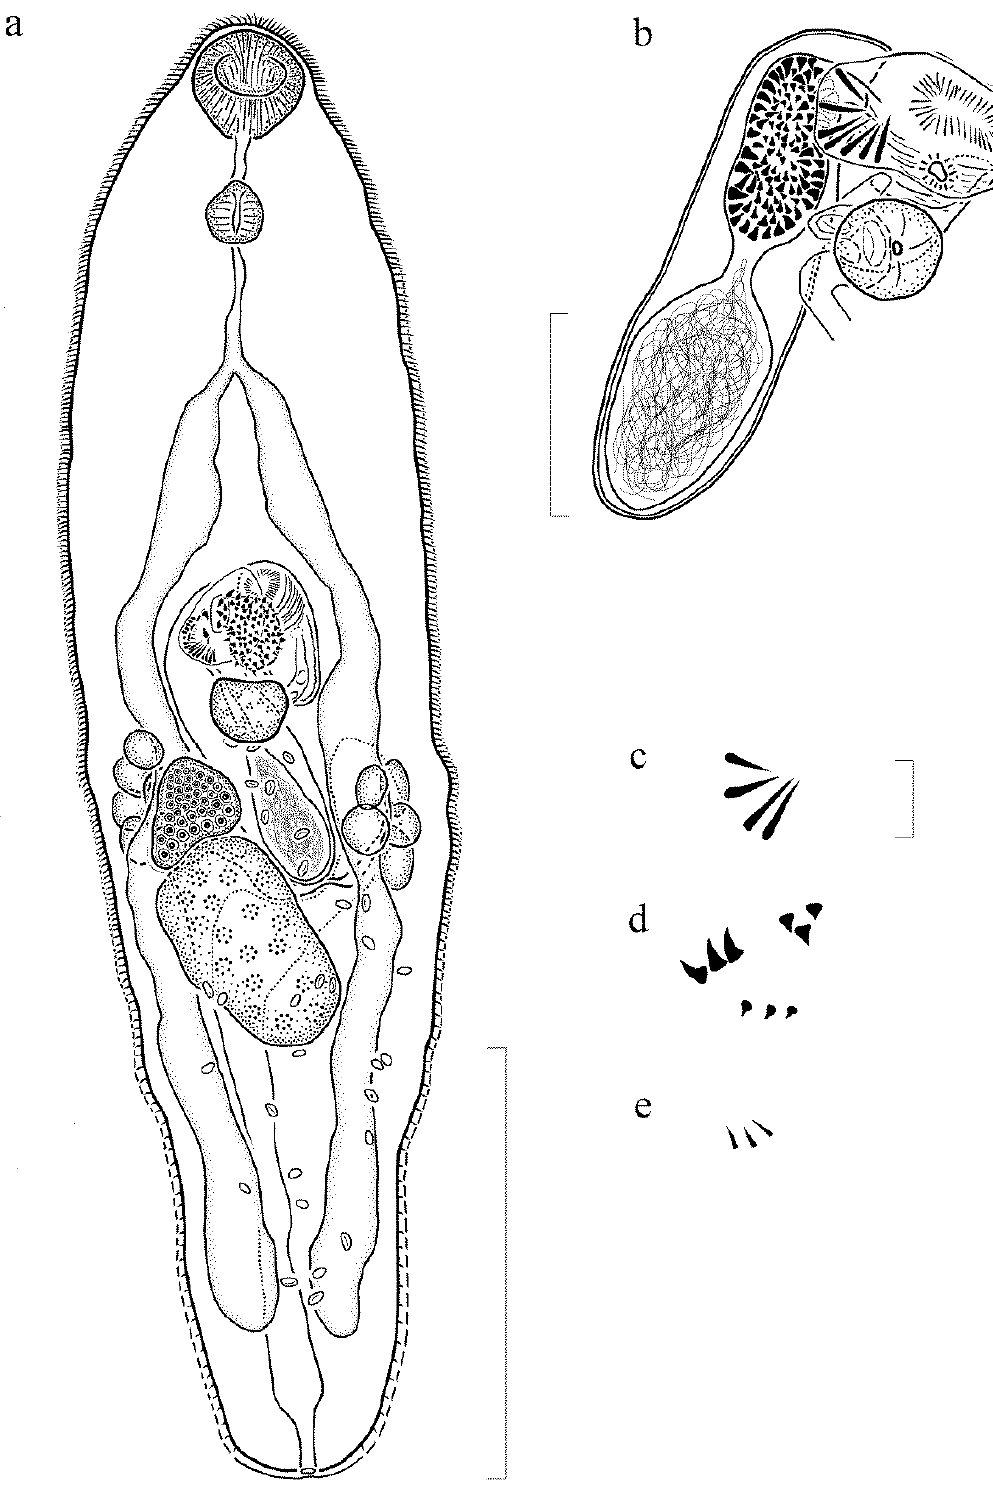
Figure 3. Genolopa minuscula n. sp. from Anisotremus surinamensis . ( a ) Ventral view, holotype, scale bar 400 µ m, note cirrus everted; ( b ) ventral view, terminal genitalia, scale bar 100 µ m, note anterior portion of terminal organ is a cross sectional view; ( c ) genital atrium spines, scale bar 40 µ m; ( d ) cirrus spines, note the different sized spines, scale bar 40 µm; ( e ) anterior terminal organ spines, scale bar 40 µm.